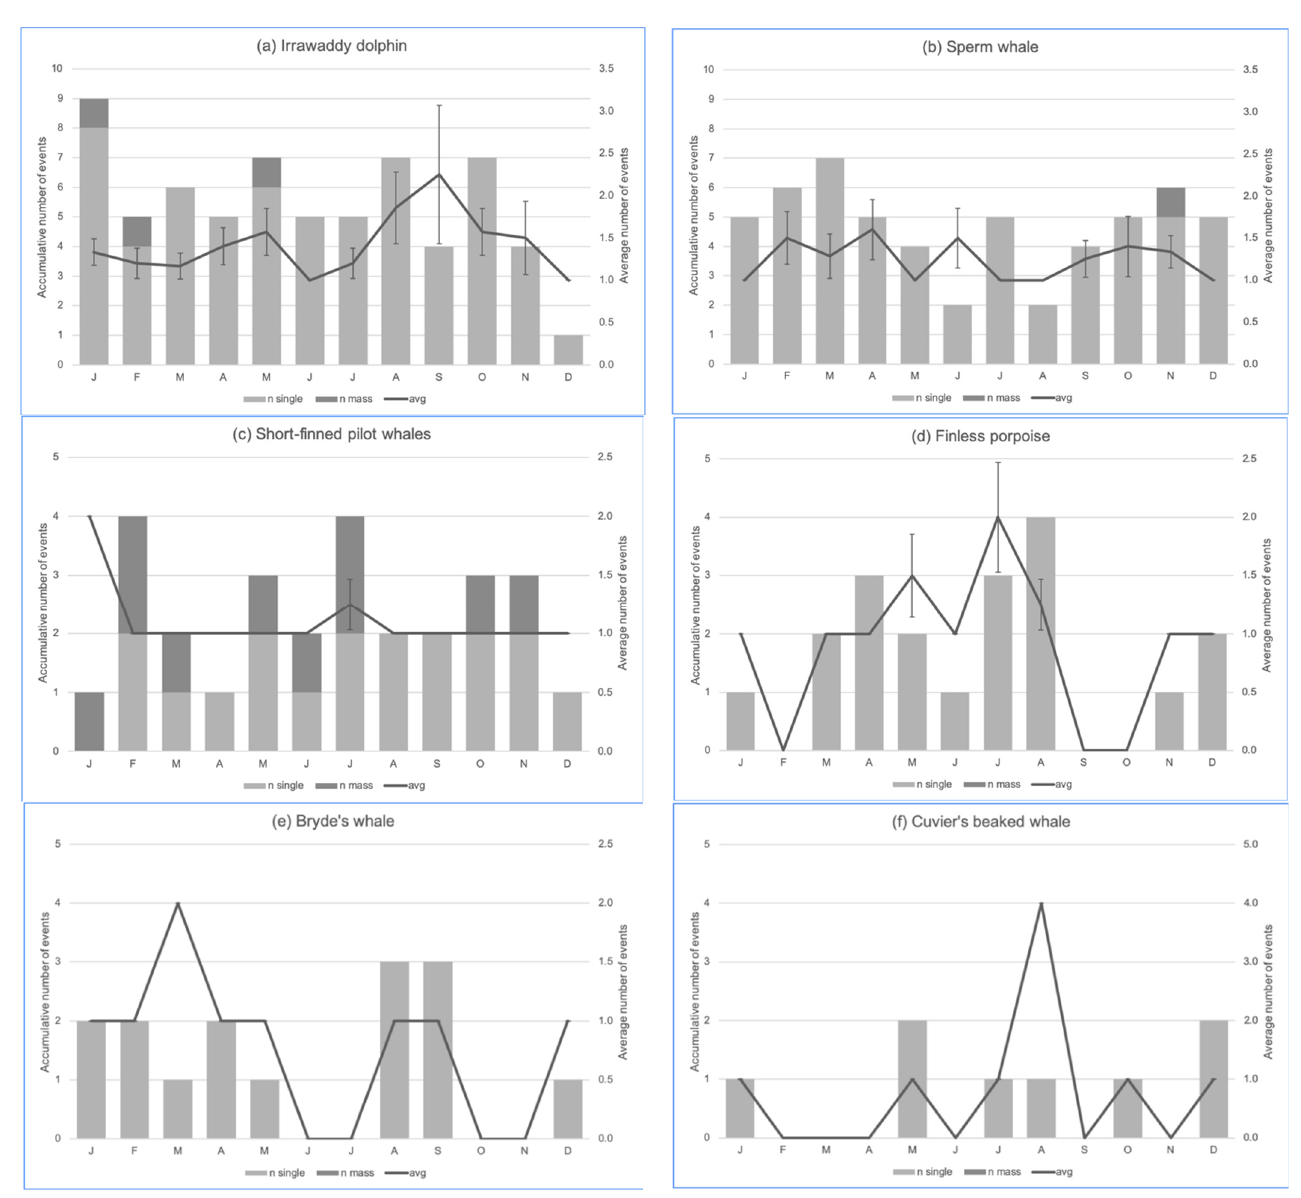
Figure 5. The monthly trend of stranding events of the six most frequently stranded cetaceans in Indonesia: ( a ) the Irrawaddy dolphin ( Orcaella brevirostris , n = 102), ( b ) sperm whale ( Physeter macrocephalus , n = 75), ( c ) short-finned pilot whale ( Globicephala macrorhynchus , n = 31), ( d ) Indo-Pacific finless porpoise ( Neophocaena phocaenoides , n = 24), ( e ) Bryde’s whale ( Balaenoptera edeni , n = 16), ( f ) Cuvier’s beaked whale ( Ziphius cavirostris , n = 11). Some species had stranding data with no associated months; thus, the cumulative counts may be less than the total events for each species.